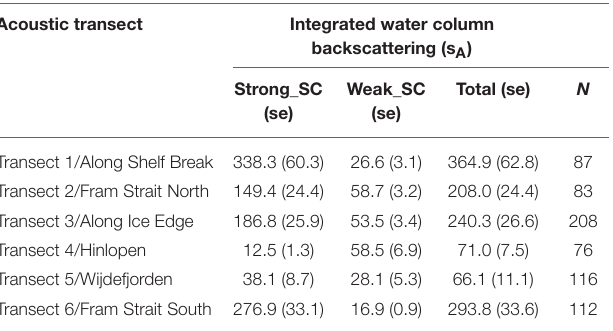
TABLE 3 | Average water column integrated s A , Nautical area scattering coefficient in units of (m 2 nmi − 2 ) at 38kHz for categories Strong_SC, Weak_SC and Total on acoustic transects 1–6 as shown in Figure 2